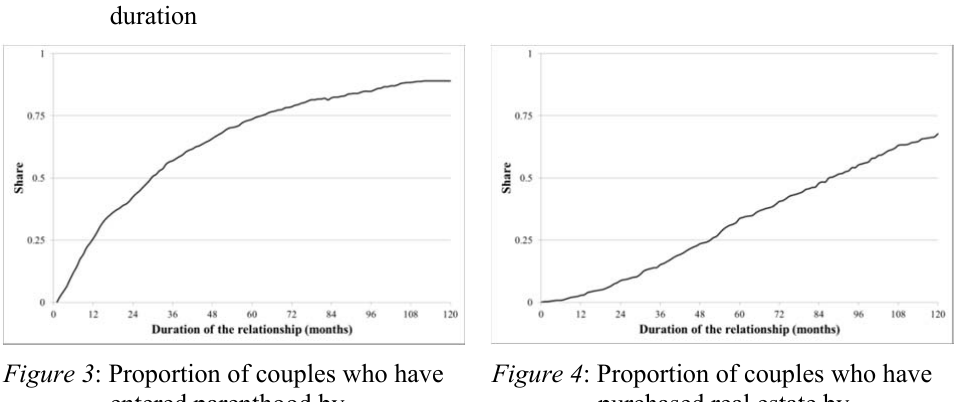
Figure 1 : Proportion of couples who have moved in together by relationship duration